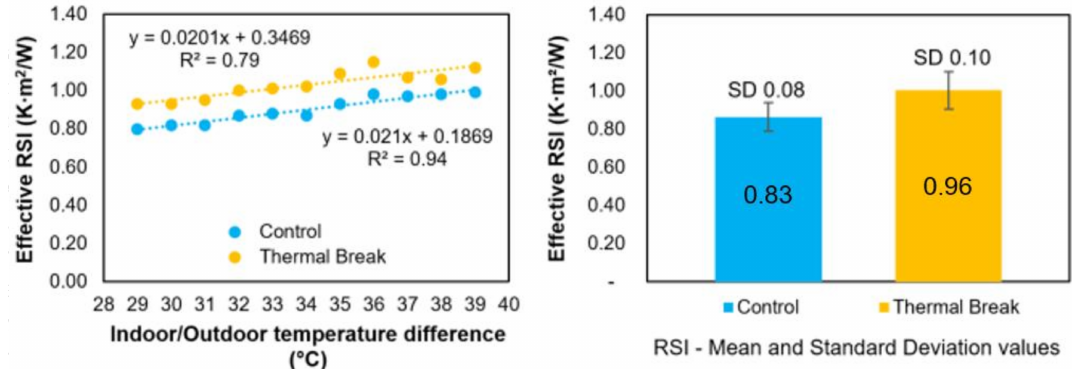
Figure 10. The e ff ective 1-D thermal resistance for approximately 1 m length from ~0.3 m to the interior of the curtain wall to ~0.6 m toward the exterior of the balcony for balcony pair#1 estimated using data from November to January during periods when the exterior–interior ∆ T was greater than 20 ◦ C and when no solar radiation was